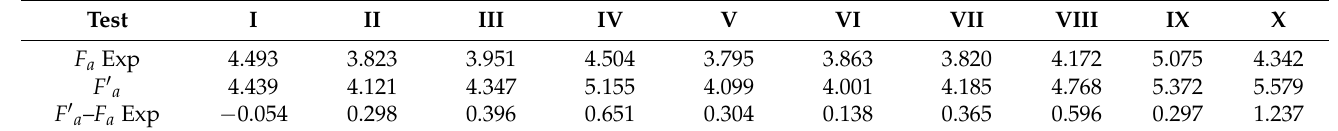
Table 6. F (cid:48) a – F a Exp.